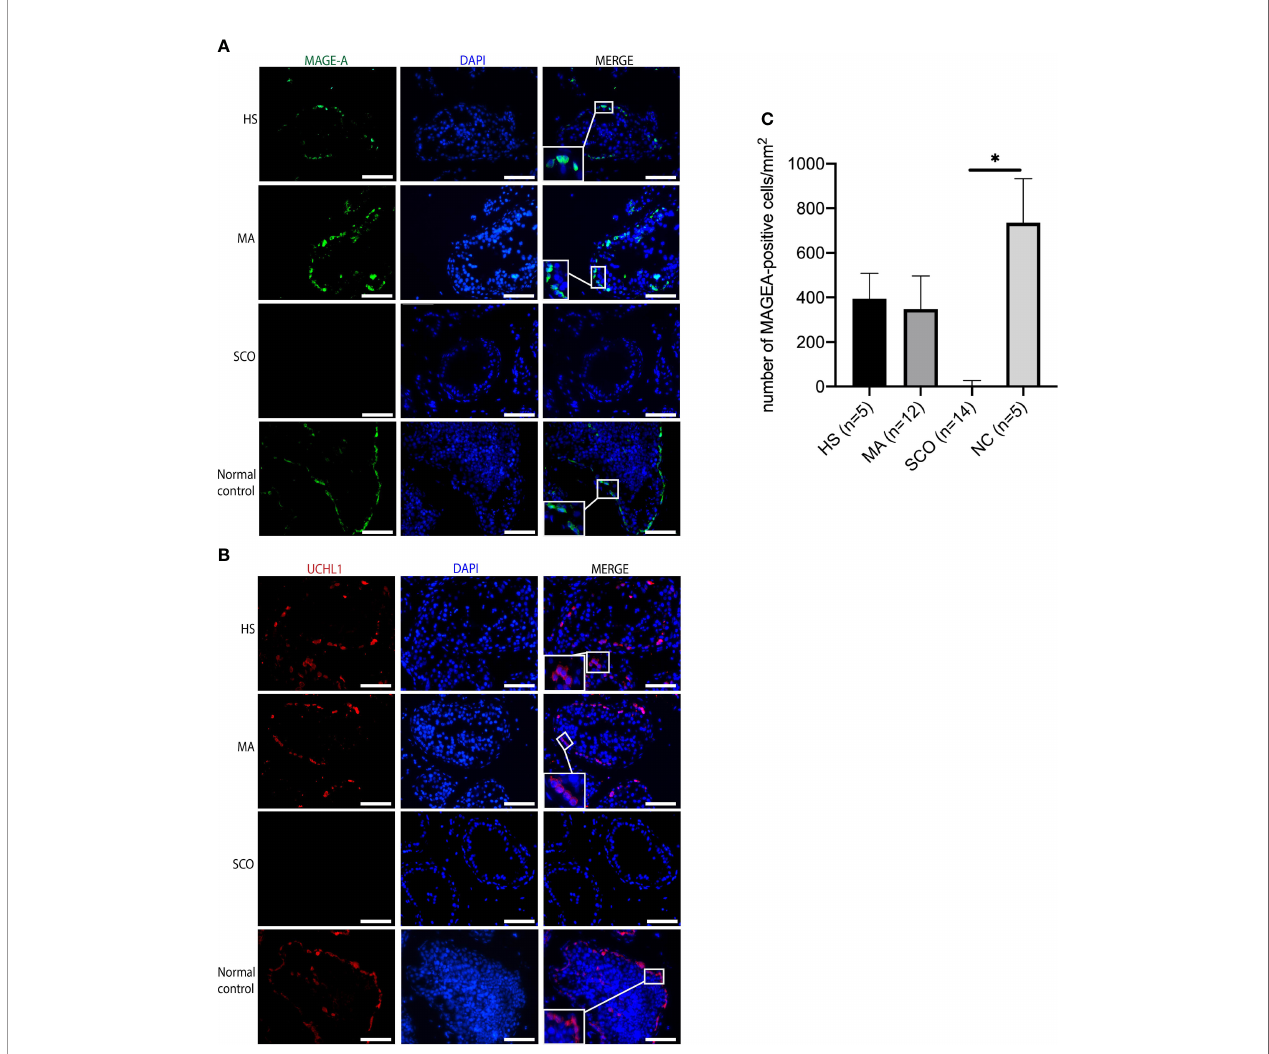
FIGURE 5 | Immuno fl uorescence staining of germ cell markers in un-dilated seminiferous tubules from HS, MA, SCO, and NC samples. (A) MAGE-A (green) for germ cells, (B) UCHL1 (red) for germ cells, DAPI (blue) for nuclear staining, Scale bar: 100 m m. (C) The number of MAGE-A-positive cells per mm 2 was counted based on ten tubules of each biopsy. Asterisk indicated signi fi cant difference between SCO and normal control group (* p <